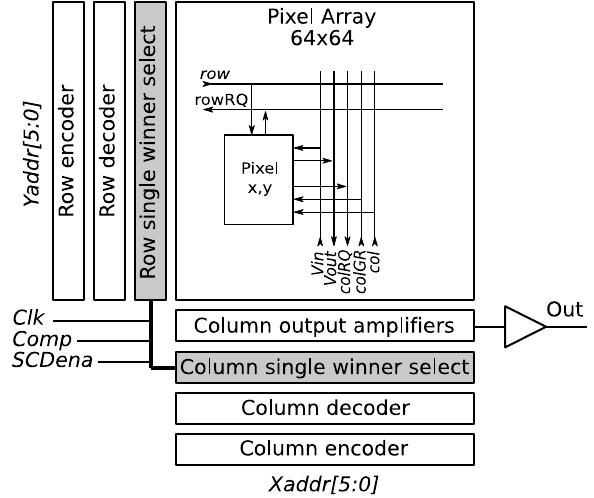
Figure 4. Sensor blocks with the digital single-winner selection circuits and signals.